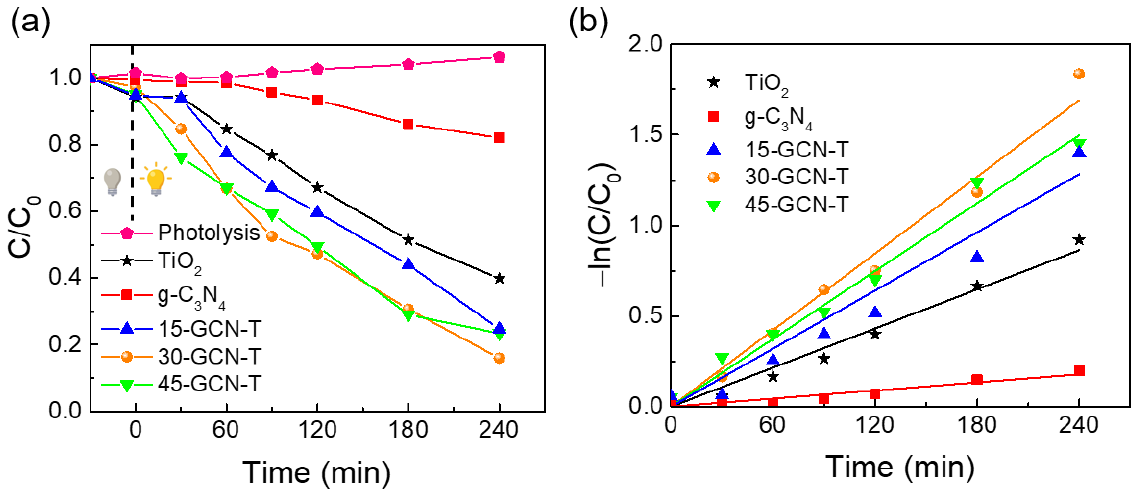
Figure 10 . ( a ) Degradation curves (C/C 0 as a function of the exposure time) under solar simulating light up to 4 h without photocatalyst (photolysis) and for TiO 2 , g-C 3 N 4 , 15-GCN-T, 30-GCN-T,45- GCN-T photocatalysts. The lines are for eye guidance only. ( b ) Pseudo-first-order kinetics for MO degradation in the presence of TiO 2 , g-C 3 N 4 , 15-GCN-T, 30-GCN-T and 45-GCN-T photocatalysts. The lines represent the linear fittings of the pseudo-first-order kinetics equation.